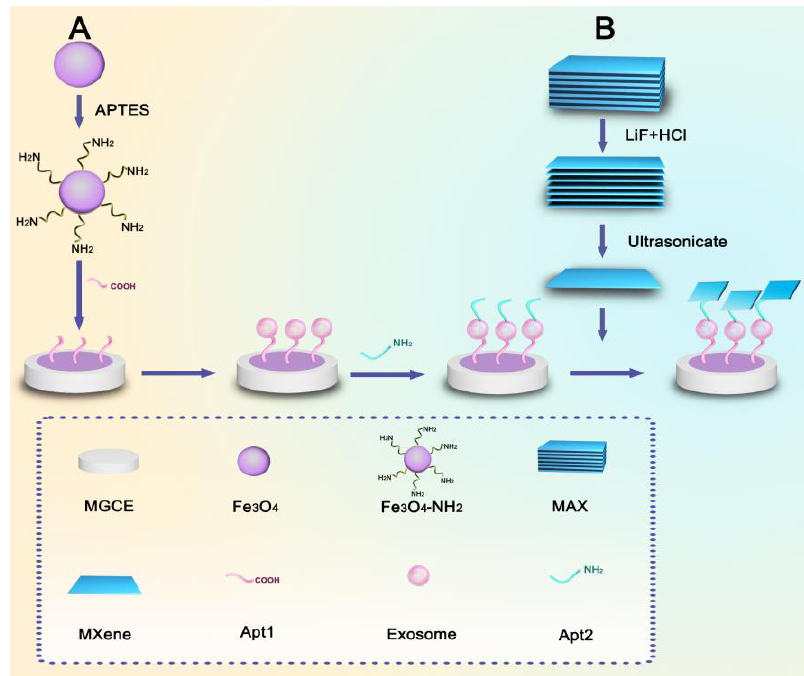
Scheme 1. Schematic illustration of the electrochemical biosensor for exosome detection.